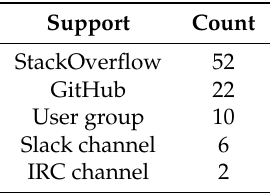
Table A19. 6.b. What is, in your experience, the most convenient ways to obtain support about Selenium from the